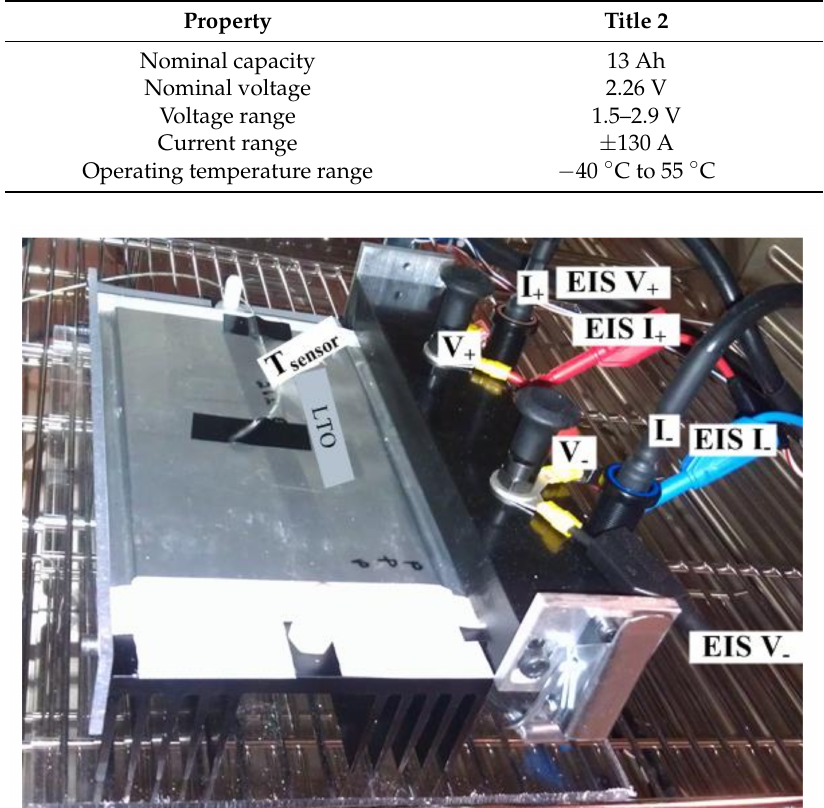
Table 1. Specification of the Li-ion battery cell used in this study.